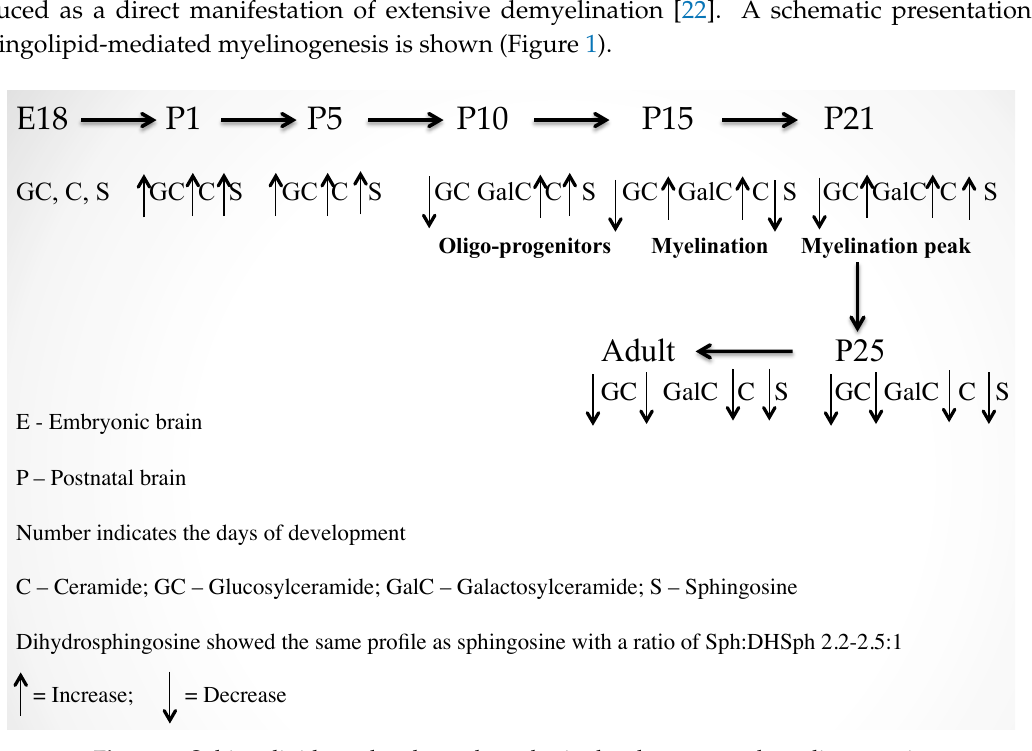
Figure 1. Sphingolipid regulated vertebrate brain development and Figure 1: Sphingolipid regulated vertebrate brain development and myelinogenesis